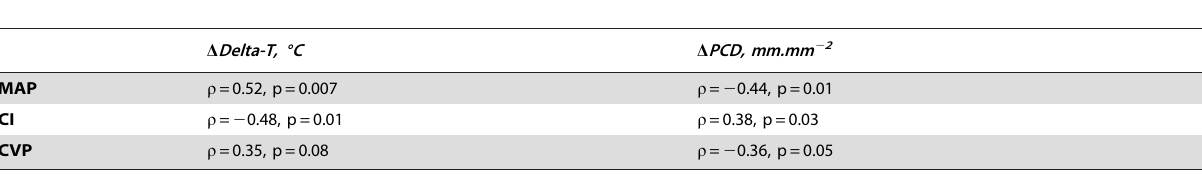
Table 4. Correlations between changes in pooled global hemodynamic and microcirculatory parameters.